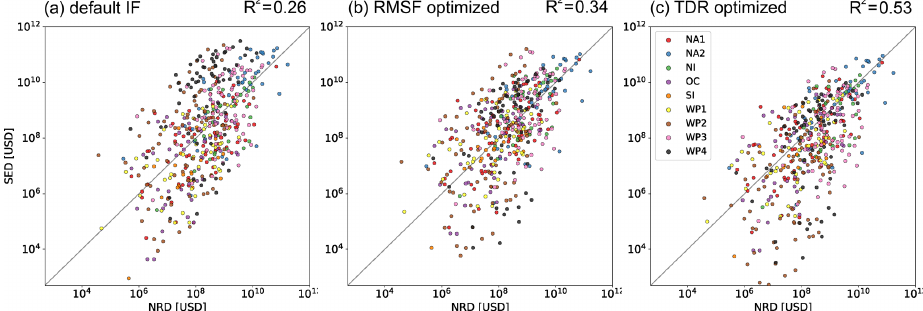
Figure A2. Simulated event damage (SED) vs. normalized reported damage (NRD) for 473 TC events worldwide computed with three different sets of impact functions: (a) uncalibrated default ( V half = 74.7ms − 1 ), (b) RMSF optimized, and (c) TDR optimized. The nine calibration regions are differentiated by color.